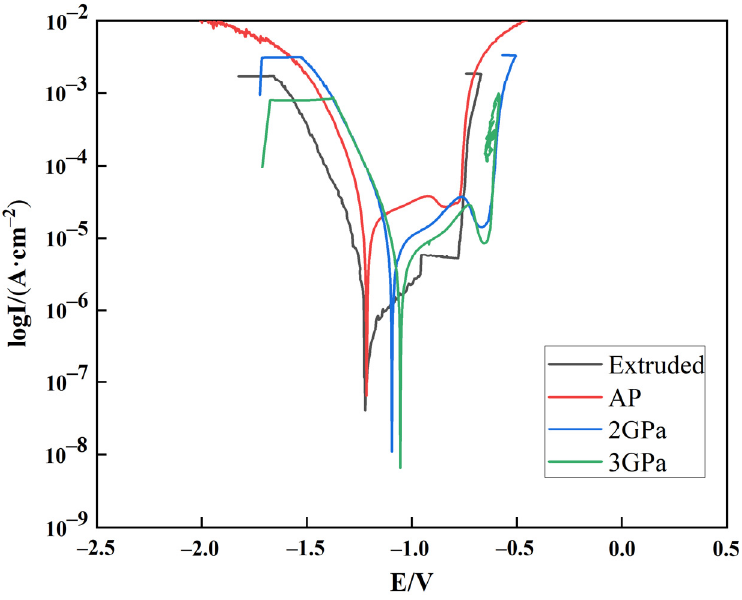
Figure 9. Potentiodynamic polarization plots for the extruded Al-Zn-Mg-Cu alloy annealed under different pressures. Table 4. Results of the polarization experiments for the extruded Al-Zn-Mg-Cu alloy annealed at different pressures measured in 3.5% NaCl solution.